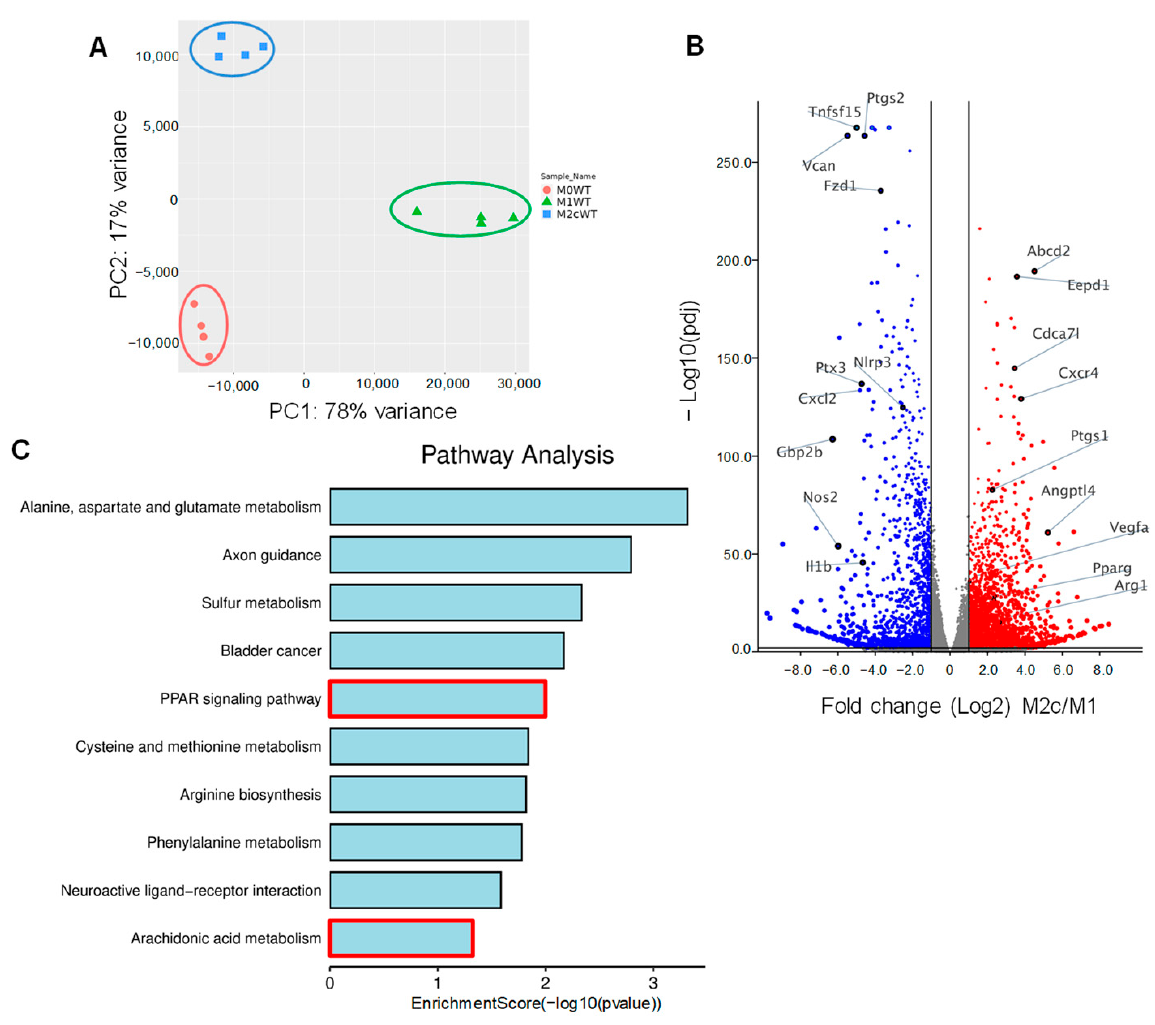
Figure 1. Impact of TGF- β -induced macrophage repolarization on gene expression. ( A ) Principle component analysis showing the clustering of RNA-seq samples from differentially polarized (M0, M1 and M2c) macrophages from wild-type (WT) mice; n = 4 mice/group. ( B ) Volcano plot showing differentially expressed genes in M1 and M2c polarized. Blue = genes significantly downregulated and red = genes significantly upregulated in M2c versus M1 macrophages. ( C ) Gene set enrichment analysis of gene expression in M1 and M2c macrophages.